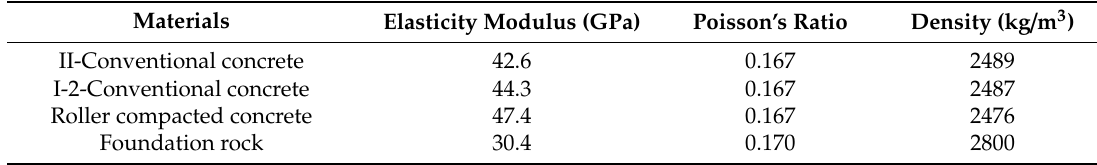
( c ) Earthquake #3 Figure 10. The horizontal displacement of point A with respect to point C (under the input angle of 75°). The maximum absolute values of the displacement time-history curve under various input angles are extracted and compared with each other, as shown in Figures 11 and 12. The dynamic response of the dam under pulse seismic motions is remarkably higher than that under non-pulse seismic motions in all cases, especially when the incidence angle is large. Figure 11 shows that with an increase of the P wave incident angle, the relative displacements first increase and then decrease. The maximum relative displacement between point A and point B under the three near-fault pulse seismic records reaches the maximum value with the input angle of 75°, and they are 7.48, 6.84, 3.54 times that with the angle of 0°, respectively. The maximum relative displacement between point A and point B under the three non-pulse earthquake records also reaches the maximum value with the input angle of 75°, and they are 4.31, 4.14, 3.02 times higher than that at the angle of 0°, respectively. The maximum relative displacement between point A and point C under the three near-fault pulse earthquake records reaches the maximum value with the input angle of 60°, and they are 2.44, 2.27, 2.81 times higher than that at the angle of 0°, respectively. The maximum relative displacement between point A and point C under the three non-pulse earthquake records also reaches the maximum value with the input angle of 60°, and they are 2.24, 2.02, 3.82 times higher than that at the angle of 0°, respectively. That indicates the traditional assumption of the wave propagating along a vertical direction cannot reasonably reflect the real situation. Figure 12 shows the maximum absolute value of the relative horizontal displacements of point A with respect to points B and C, respectively. The relative horizontal displacement increases with the ratio of PGV/PGA. (Although the PGV/PGA ratio of Earthquake #3 is not the largest, it has the longest duration, so the damage of the dam is serious [52] and the curves have a slight drop at the